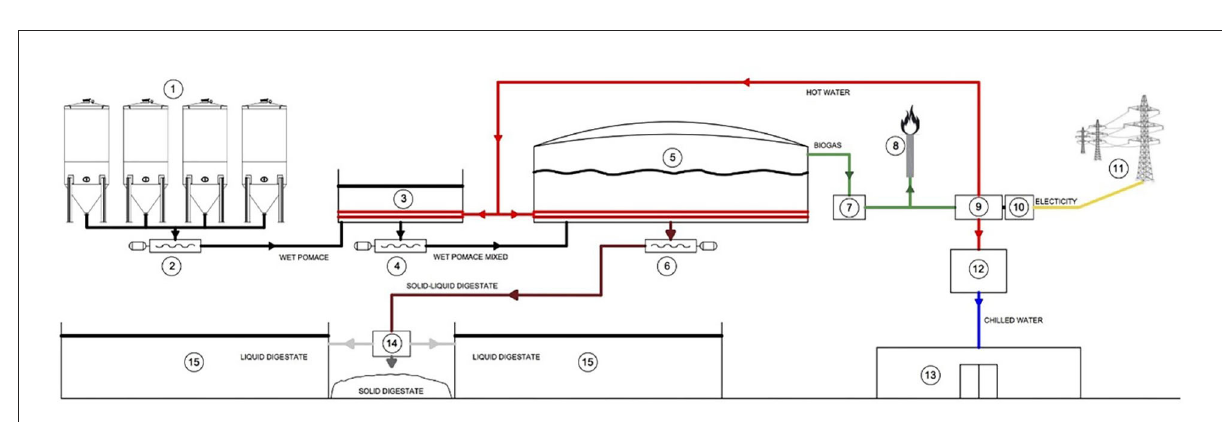
FIGURE2 Scheme of the biogas plant. (1) Wet pomace tanks, (2) pomace stator pump, (3) hydrolysis tank, (4) mixed pomace stator pump, (5) anaerobic digester, (6) digestate stator pump, (7) condensate pit, (8) biogas torch, (9) endothermic engine, (10) electric generator, (11) electricity grid,